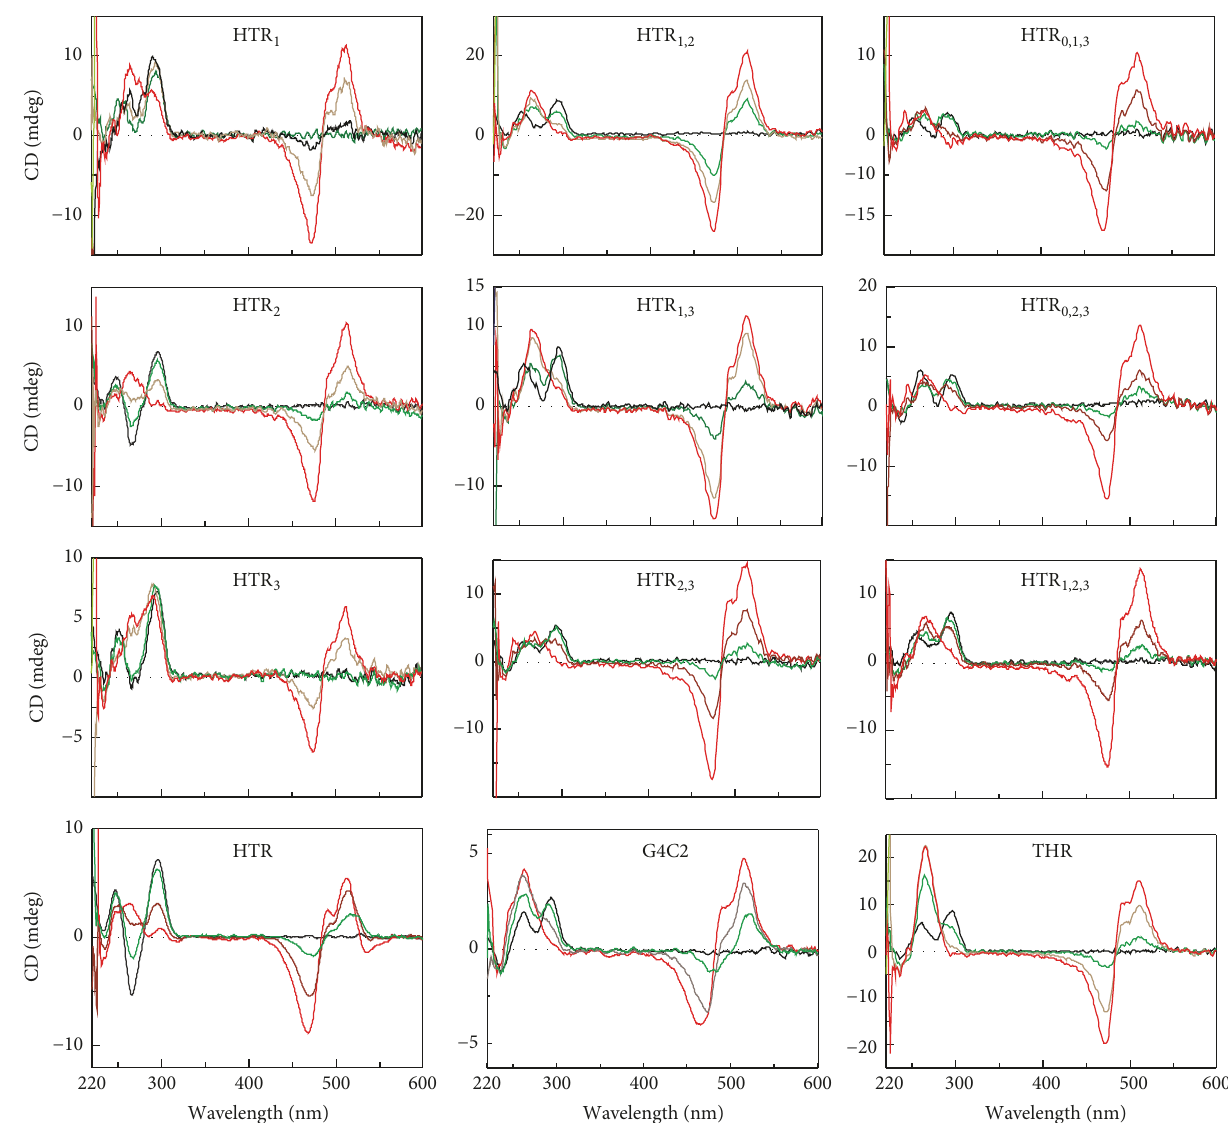
Figure 4: The CD titration spectra of 27 𝜇 M DNA sample with TO; 0, 2.5, 5, and 7.5 molar equivalents of TO represent by black, green, brown, and red lines, respectively. Each sample was measured in a modified 25 mM mBR buffer containing 50 mM